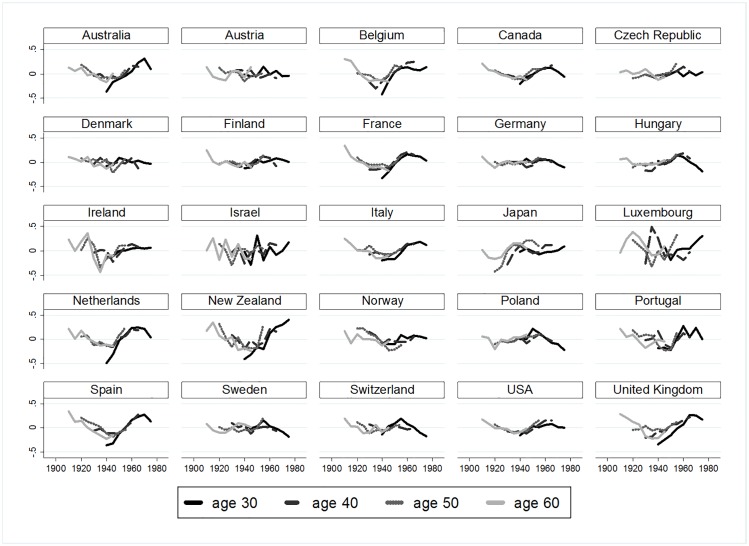
Residuals of logged suicide rates after control of (AP) by country.